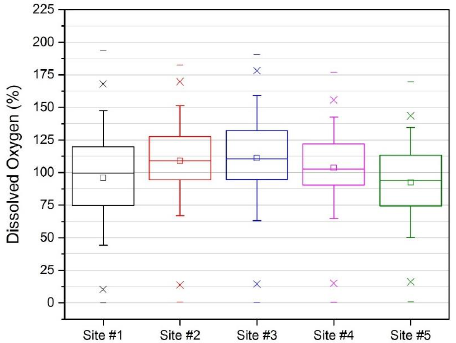
Figure 6. Dissolved oxygen (% of saturation) and streamflow (L s −1 ) at each gauging site ( n = 5) during study period (October 2010–May 2014) in Hinkson Creek Watershed, MO, USA. Red lines depict minimum and maximum thresholds established by Missouri Department of Natural Resources.